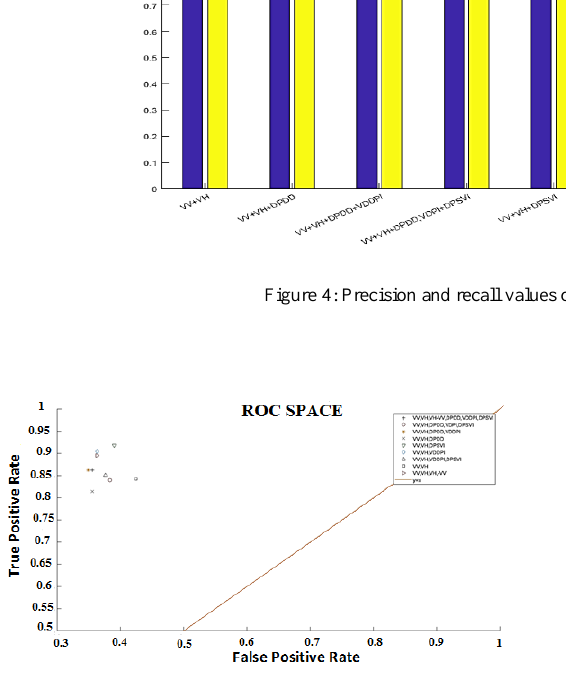
Figure 3: ROC SPACE for different combination of features in Sentinel-1